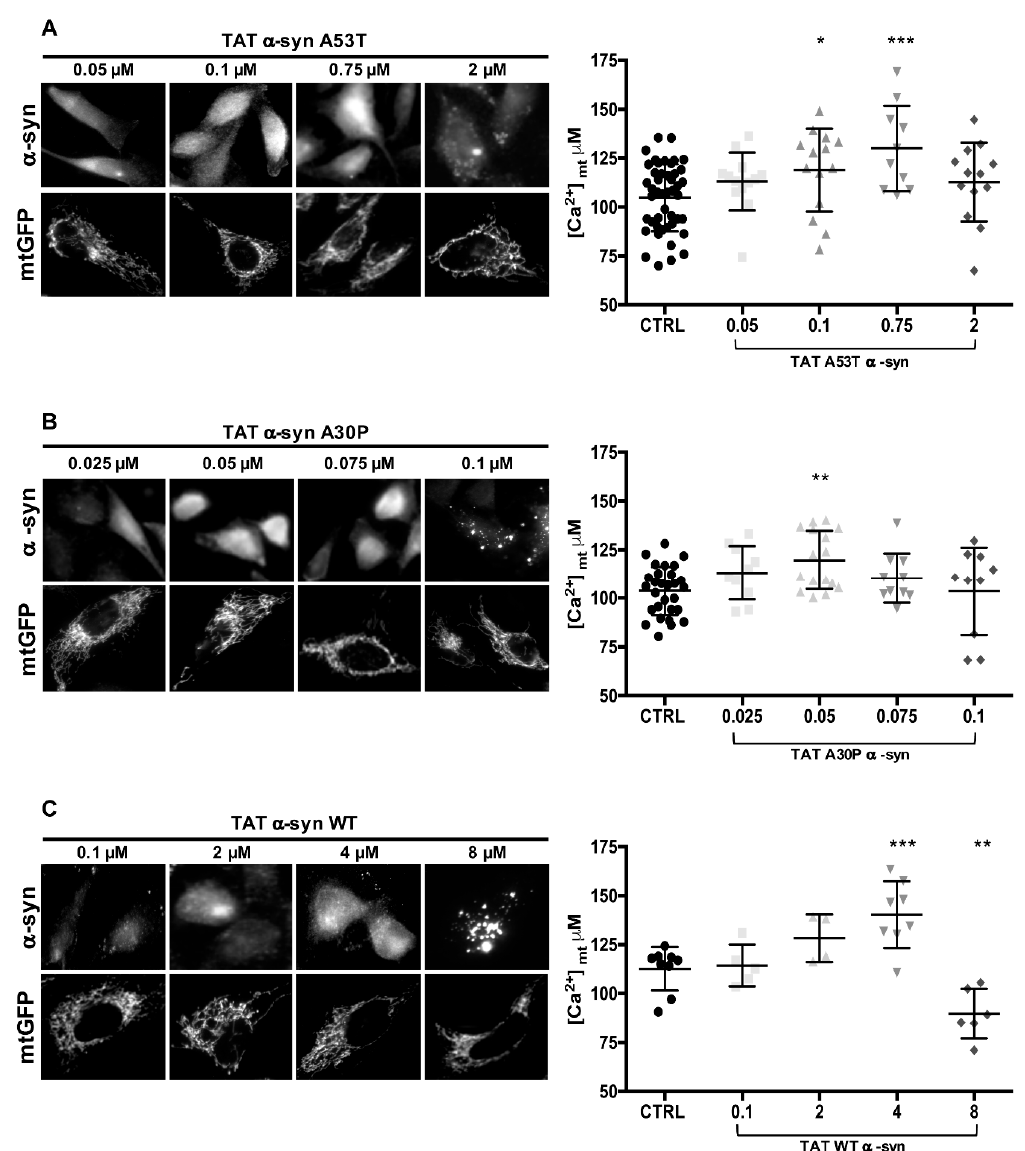
Figure 4. TAT-mediated delivery of A53T and A30P α -synuclein mutants induces dose-dependent α -syn redistribution and different effect on mitochondrial Ca 2+ transients. HeLa cells were transfected with mtGFP or mtAEQ and then incubated with the indicated doses of TAT A53T ( A ) or TAT A30P ( B ) or TAT WT ( C ) α -syn. Immunolocalization of TAT mutant α -syn ( top ) and mitochondrial network ( bottom ) are revealed by α -syn primary antibodies and mtGFP fluorescence, respectively. The images revealing mitochondrial morphology were randomly acquired from TAT α -syn treated cells. Mitochondrial Ca 2+ measurements were performed in HeLa cells upon treatment with TAT A53T or A30P or WT α -syn at the indicated doses. Panels on the right show the scatter plots representing the mean [Ca 2 + ] mt peak values upon cell stimulation with histamine. Results are the mean ± SD obtained from at least three independent experiments. *, p < 0.01; **, p < 0.005; ***, p < 0.0005. One-way ANOVA test retrieved a p -value of 0.0001, for multiparametric analysis a Dunnet’s post-test was